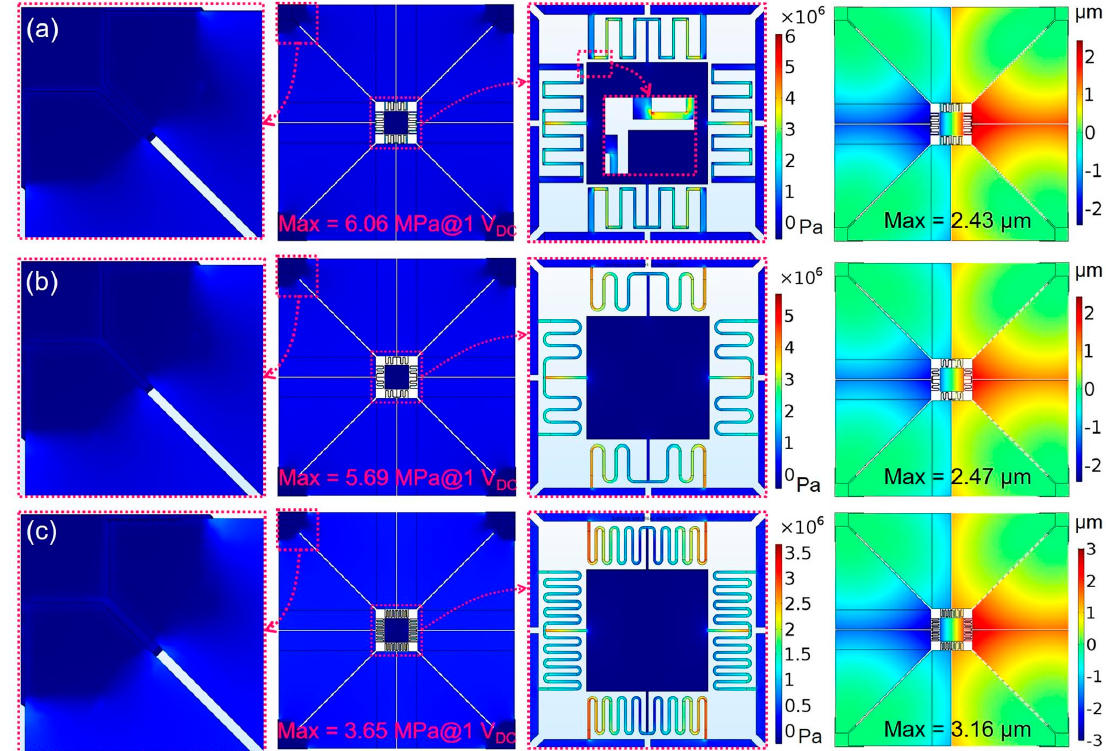
Figure 5. FEM simulations of material principal stress and defection in three piezoelectric MEMS mirrors with different meandering spring designs at 1 V DC driving voltage: ( a ) rectangular-shaped spring, ( b , c ) S-shaped